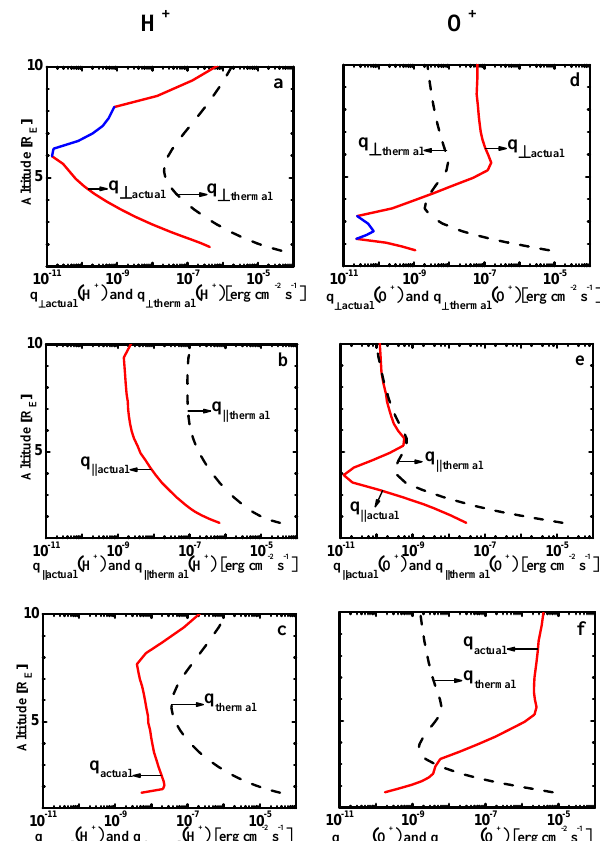
Figure 3. Altitude profiles for actual (solid lines, the line shows the Figure3:PW magnitude of the actual heat flux, with red color indicating posi- tive values and blue color indicating negative values) and “thermal- ized” heat fluxes (dashed lines) of H + ions (left panels) and O + ions (right panels) in the polar wind region. The heat fluxes con- sidered here are perpendicular heat fluxes (top panels), parallel heat fluxes (middle panels) and total heat flux (bottom panels). The unit of the heat flux is ergcm − 2 s − 1 . The arrow and the symbol next to it represent a label for the corresponding